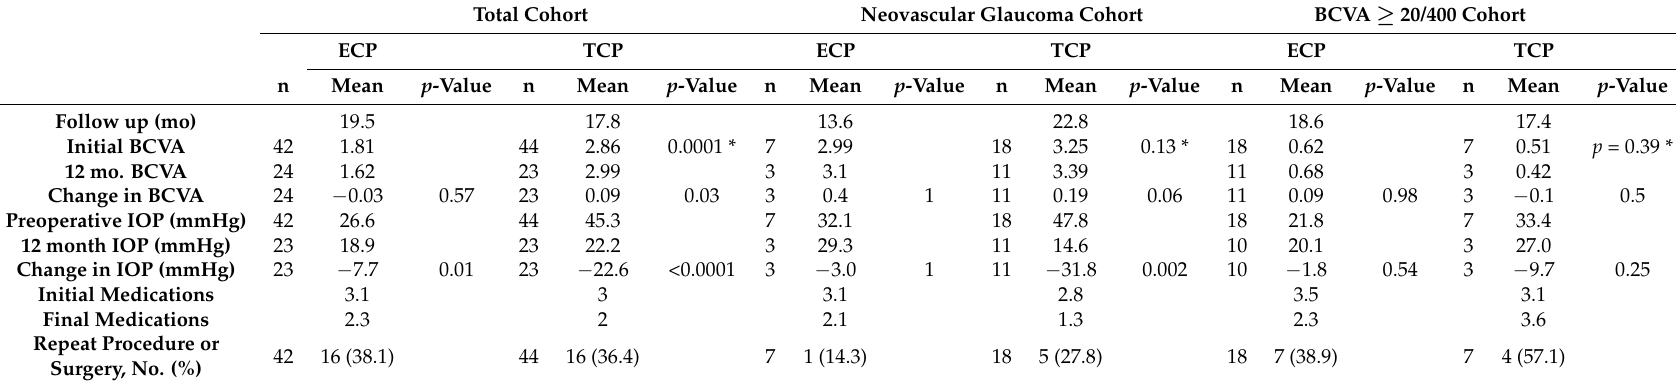
Table 2. Intraocular pressure, vision, and medications before and after ECP and TCP as seen in all eyes, neovascular eyes, and eyes with BCVA 20/400 or